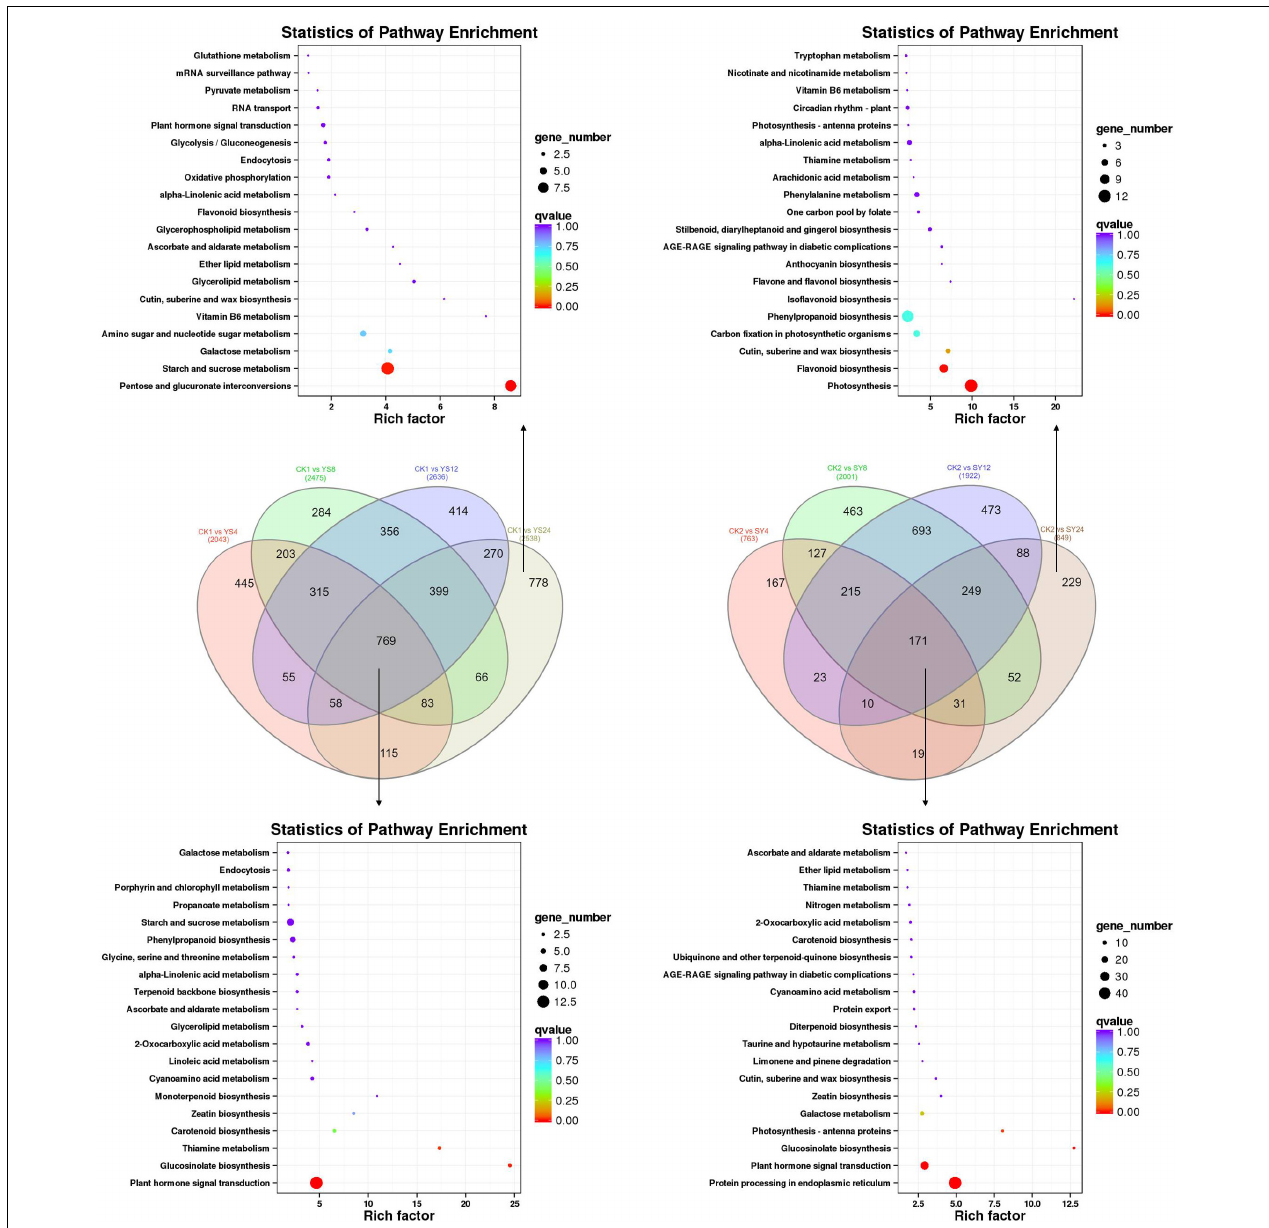
FIGURE 5 | Differentially expressed genes in pollination combinations YS and SY. Venn diagrams show the common and specific DEGs in each pollination combination. KEGG enrichment scatter plots indicate the pathways in which common and specific DEGs were enriched. Y, Yiduo; S, Shixia; CK1, Yiduo sepal-pistil before pollination; CK2, Shixia sepal-pistil before pollination. The numbers with treatments represent time after